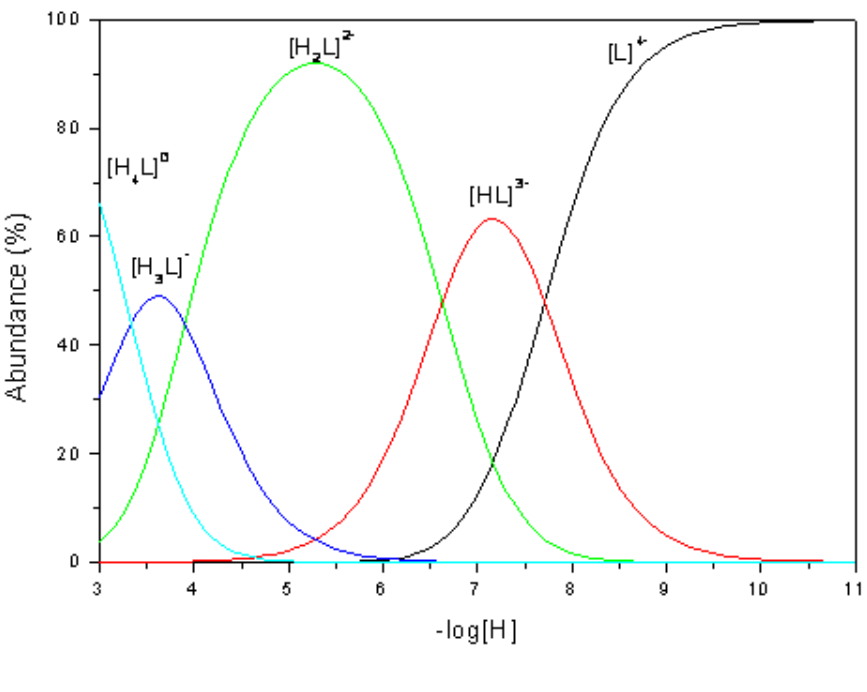
Figure 2. Calculated species distribution plots for 3